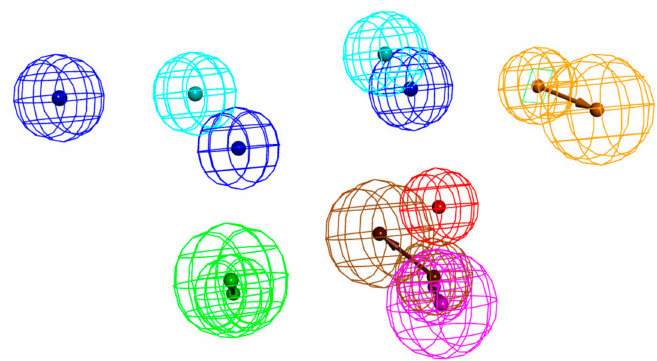
Figure 12. Superimposition of Hypo 1A and Hypo 1B. As the figure shows, in Hypo 1A, the hydrophobic point is light blue, the hydrogen bond acceptor is green, the hydrogen bond donor is purple, and the aromatic ring point is orange. In Hypo 1B, the hydrophobic point is Lyons blue, the positive ionizable point is red, and the hydrogen bond donor is brown.